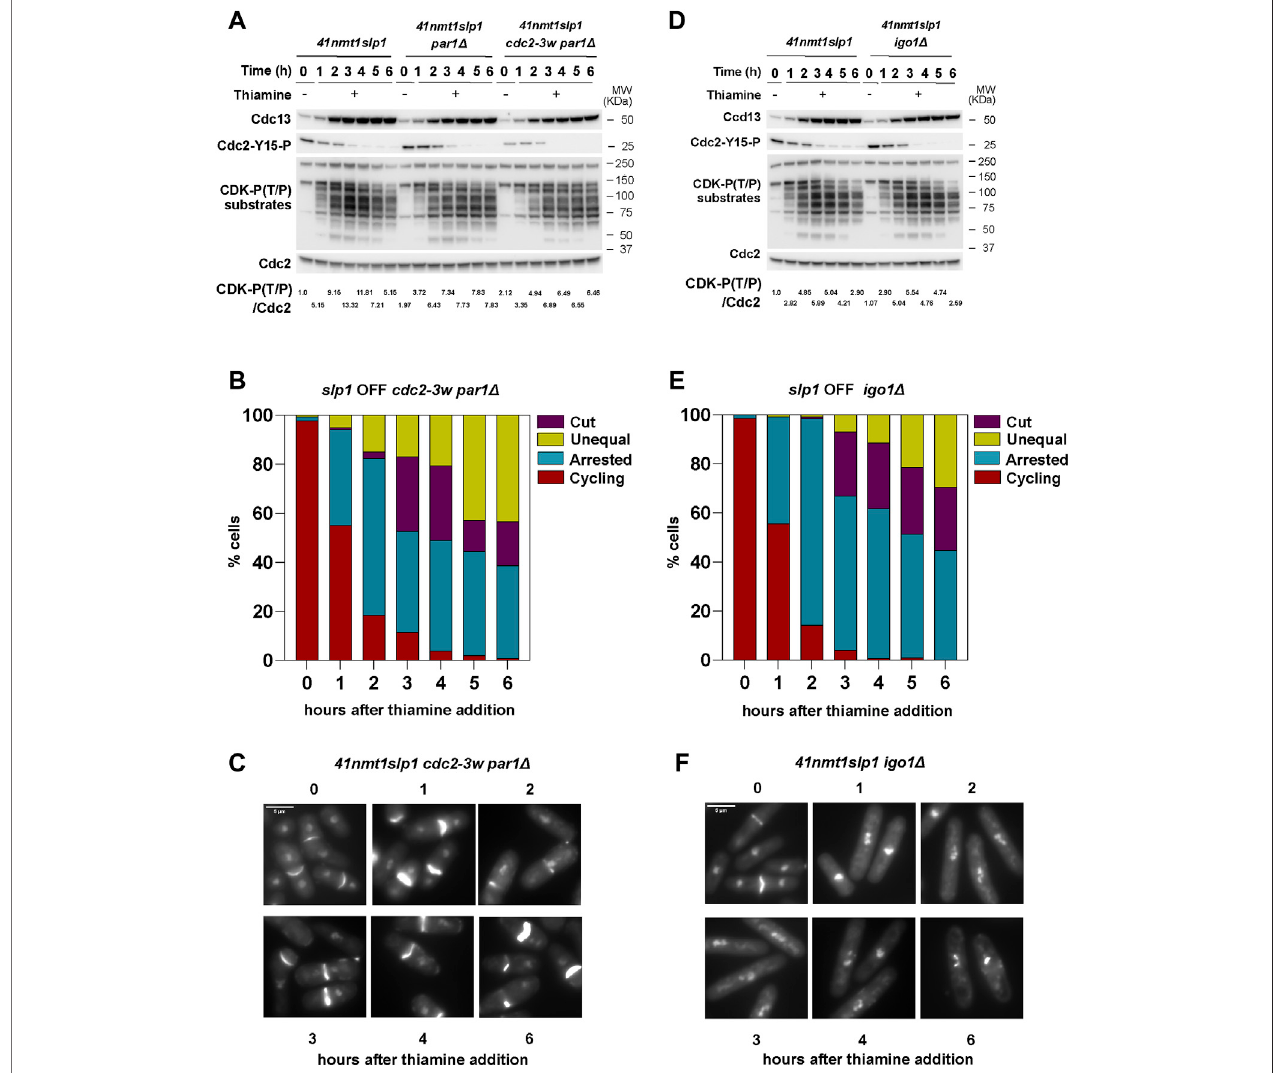
FIGURE 4 | Interplay between CDK and PP2A-B55 Pab1 in the regulation of septation. (A – F) Cells were grown exponentially in EMM ( p41-nmt1 promoter induced) and shifted to EMM +T ( p41-nmt1 promoter repressed) at 30 ° C. Samples were collected at the indicated time points for microscopy and western blot. (A,B) Cdc13 levels,phosphorylationatT/PsitesinCDKsubstratesandCdc2phosphorylatedatY15in p41-nmt1:slp1 , p41-nmt1:slp1par1 Δ andp41-nmt1:slp1cdc2-3wpar1 Δ (A) or p41-nmt1:slp1 and p41-nmt1:slp1 igo1 Δ strains (B) were detected by western blot. Cdc2 (PSTAIR) was used as a protein loading control. The numbers under the western blot indicate CDK-substrate Phosphorylation (P-T/P) quanti fi cation relative to Cdc2. (C,D) The percentage of cycling cells, metaphase-arrested cells, and arrested cells that underwent cytokinesis (cut or unequal) in p41-nmt1:slp1 cdc2-3w par1 Δ (C) and p41-nmt1:slp1 igo1 Δ (D) were determined at the indicated time points after theaddition ofthiaminetothe culture. Atleast 200cells were counted per time point. (E,F) Representative images ofmitotic featuresdistributions from DAPI and Blankophor-stained ethanol- fi xed cells in (C,D) . Scale bar 5 µm.